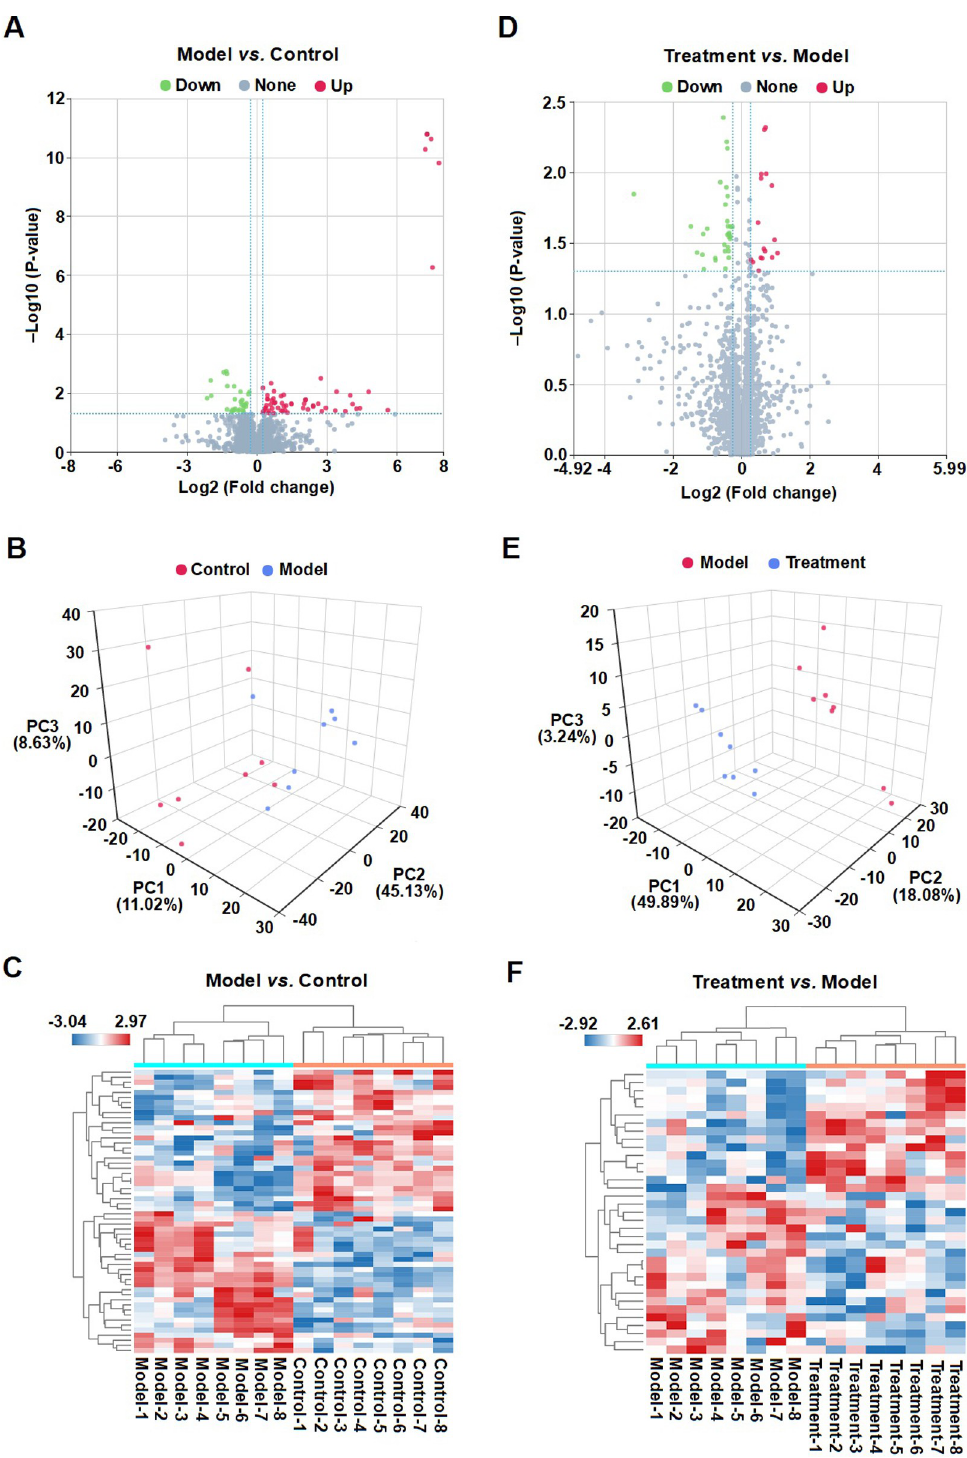
Fig 5. Influence of the MMWA treatment on the levels of serum metabolites. (A) Volcano plot of differential metabolites between the control group and the model group. (B) OPLS-DA score plots of serum samples from the control group and the model group in positive ion mode. (C) Heatmap analysis of differential metabolites between the control group and the model group. (D) Volcano plot of differential metabolites between the model group and the treatment group. (E) OPLS-DA score plots of serum samples from the model group and the treatment group in positive ion mode. (F) Heatmap analysis of differential metabolites between the model group and the treatment group.